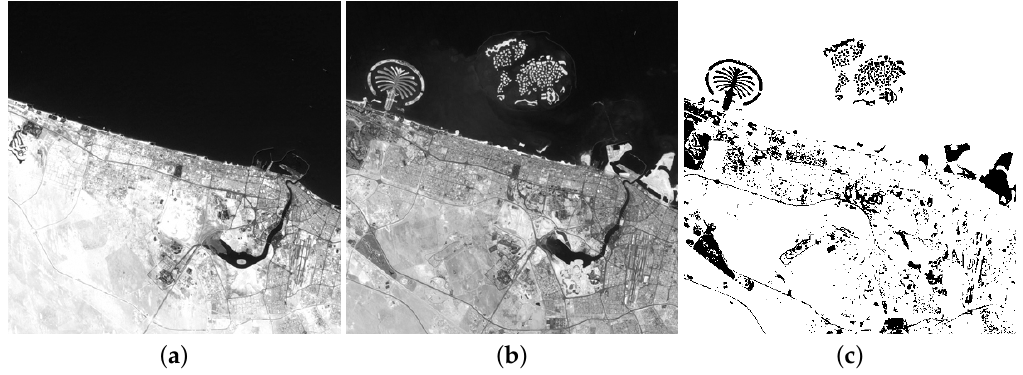
Figure 5. Band 2 of the multitemporal images of Dubai City, UAE ( a ) acquired on 14 January 2001, ( b ) acquired on 18 February 2002, and ( c ) Reference Change